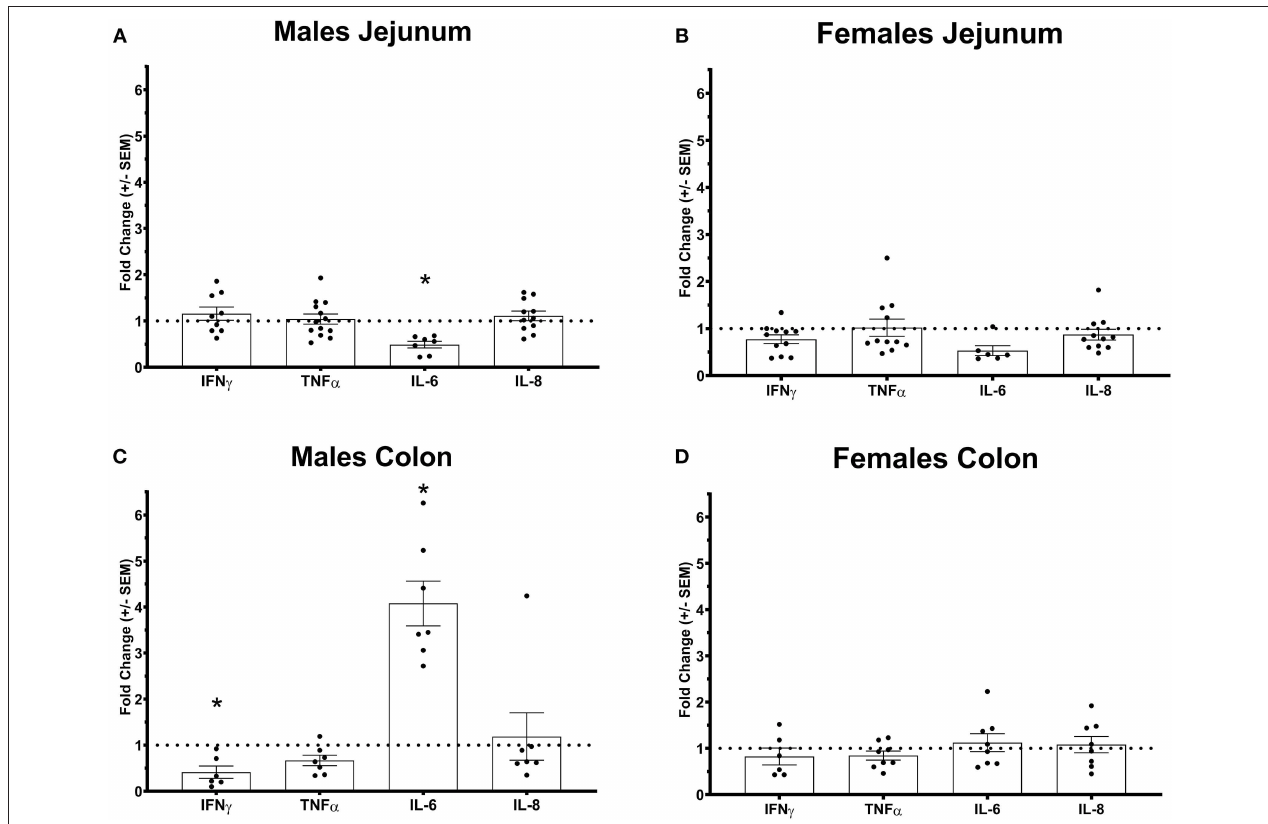
FIGURE 2 | Pro-inflammatory cytokines gene expression profile in Ztm intestine: A) Down-regulated IL-6 in the jejunum of Ztm males ( n = 13). B) Pro-inflammatory cytokines profile in and g the jejunum of Ztm females ( n = 10). C) Down-regulated IFN up-regulated IL-6 in the colon Ztm males ( n = 7). D) Unaltered Pro-inflammatory cytokines profile in the colon of Ztm females ( n = 8). mRNA expression was analyzed by qPCR, normalized to WT, and expressed as fold regulation. Statistical analysis was performed by the non-parametric Mann-Whitney test comparing each gene to its WT counterpart. * p <